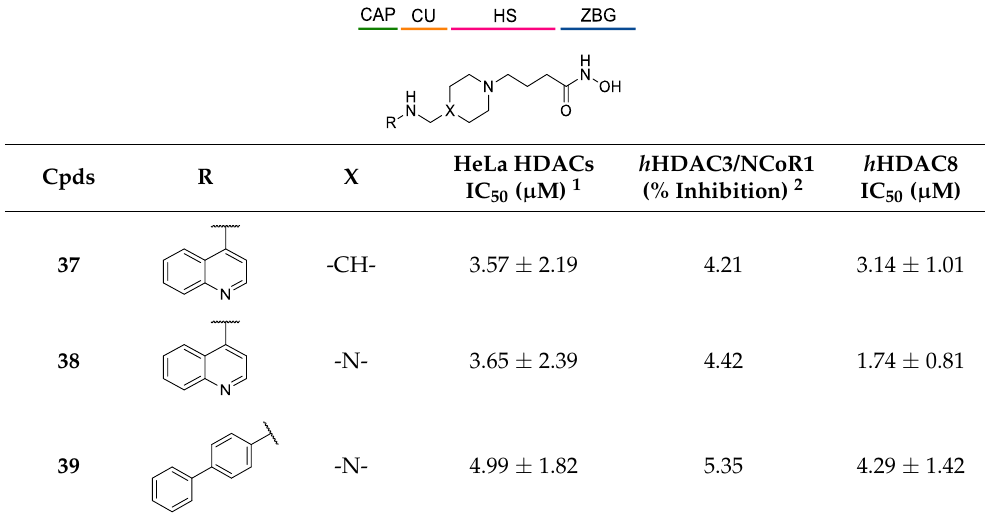
Table 7. General structure and IC 50 values of 37 , 38 , and 39 [146].